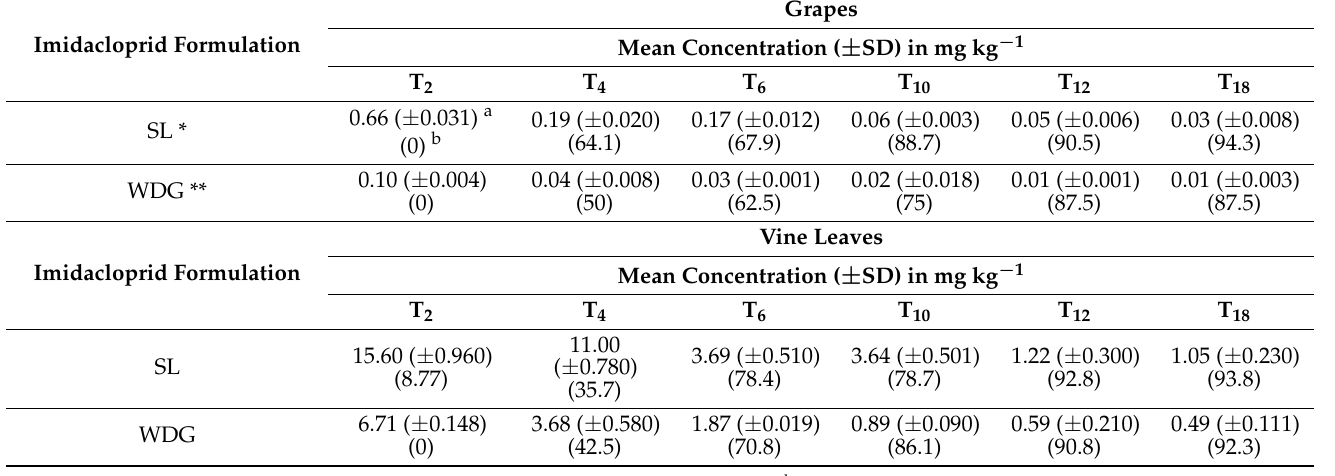
Imidacloprid Formulation